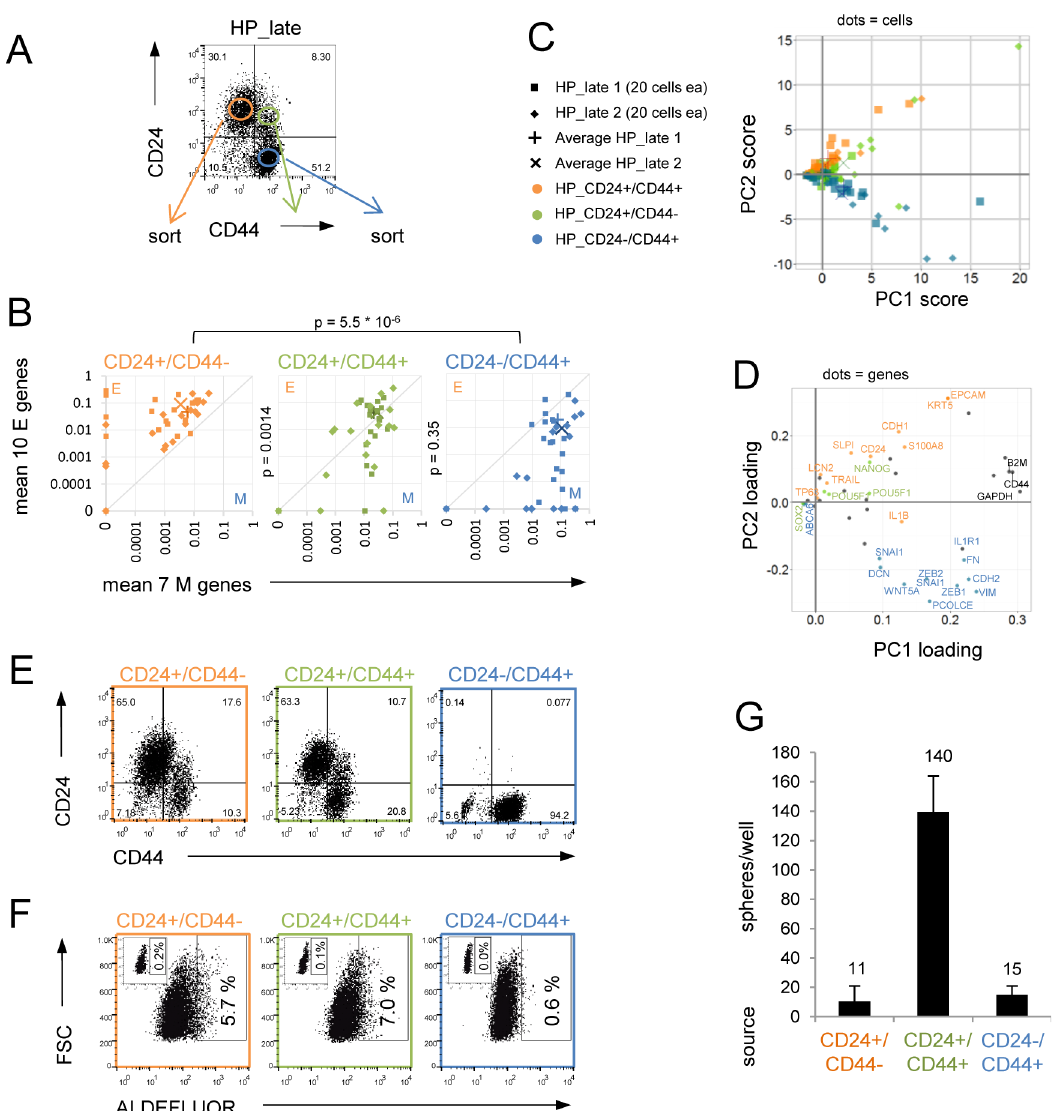
Fig 5. CD24+/CD44+ cells are hybrid E/M cells and have increased stem-like properties. (A) CD24/CD44 flow cytometry profile of HP_late cells. (B) Single cell qPCR analysis of 20 individual cells sorted from each of the six indicated CD24/CD44 subpopulations (from two independently passaged HP_late cell-lines). Mean expression of 10 E and 7 M genes (as in Fig 3) is visualized in the E-M state space. The crosses mark the average expression within the three different CD24/CD44 subpopulations (40 cells). Indicated p-values were determined using a cross-match test by comparing mean of E gene expression and/or M gene expression between indicated groups of single cells (S5 Table). (C) Principal component (PC) projections of the 120 individual cells as tested in (B) for the three different subpopulations colored according to their CD24/CD44 origin are shown. (D) PC loading projections of the 48 genes as tested in (B), showing the contribution of each gene to the first two PCs. E genes are colored in orange, M genes in blue, pluripotency genes in green, and housekeeping genes in black. (E) CD24/CD44 flow cytometry analysis of cells cultured under standard adhesion conditions for 10 days that had been freshly sorted from 100 cells of the three subpopulations from (A). (F) Assessment of ALDH1 activity in cultured cells derived from the three subpopulations (E) using the ALDEFLUOR assay. Gate shows percentage of ALDH1+ cells. Small insets show the negative control cells incubated with DEAB. (G) Mammosphere- forming ability per 1,000 sorted cells of the three HP_late derived cell populations (A) after two weeks in